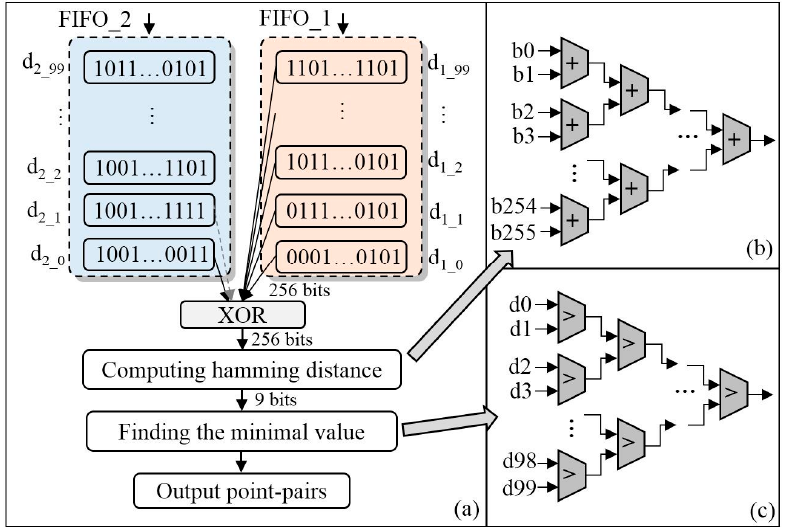
Figure 9. ( a ) Implementation process of matching; ( b ) Hamming distance computation; ( c ) Locating of the minimal value.